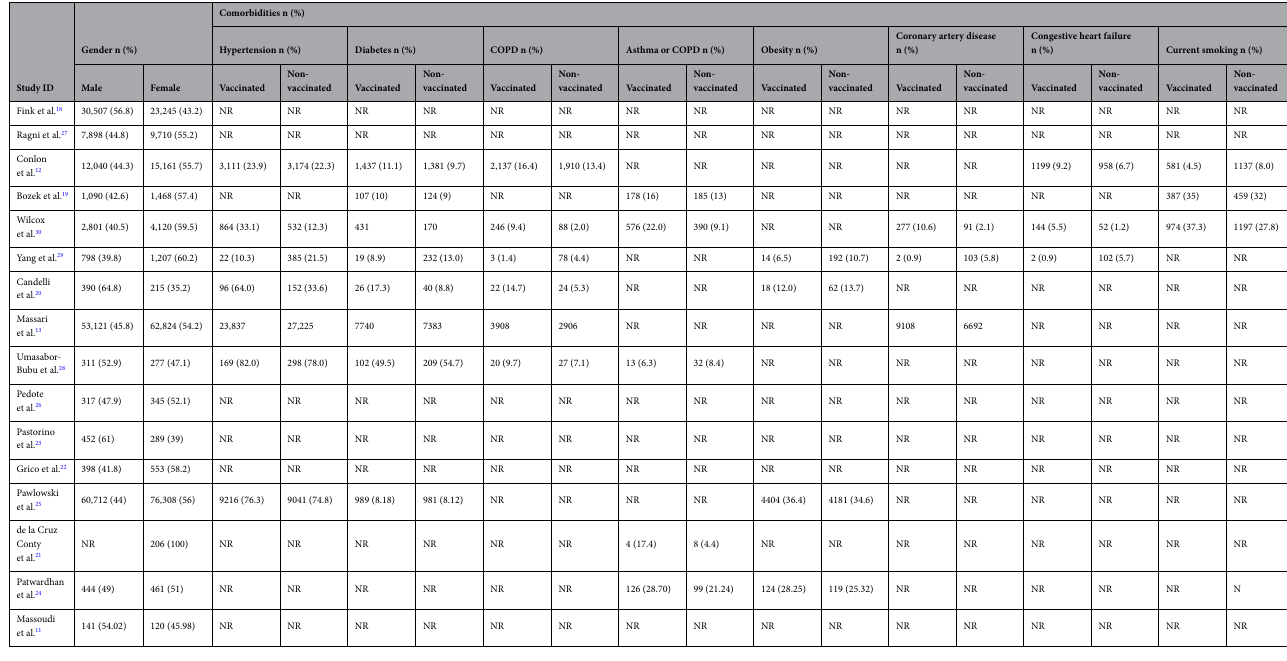
Table 2. Baseline characteristics of patients in the included studies. COPD Chronic obstructive pulmonary disease, NR Not